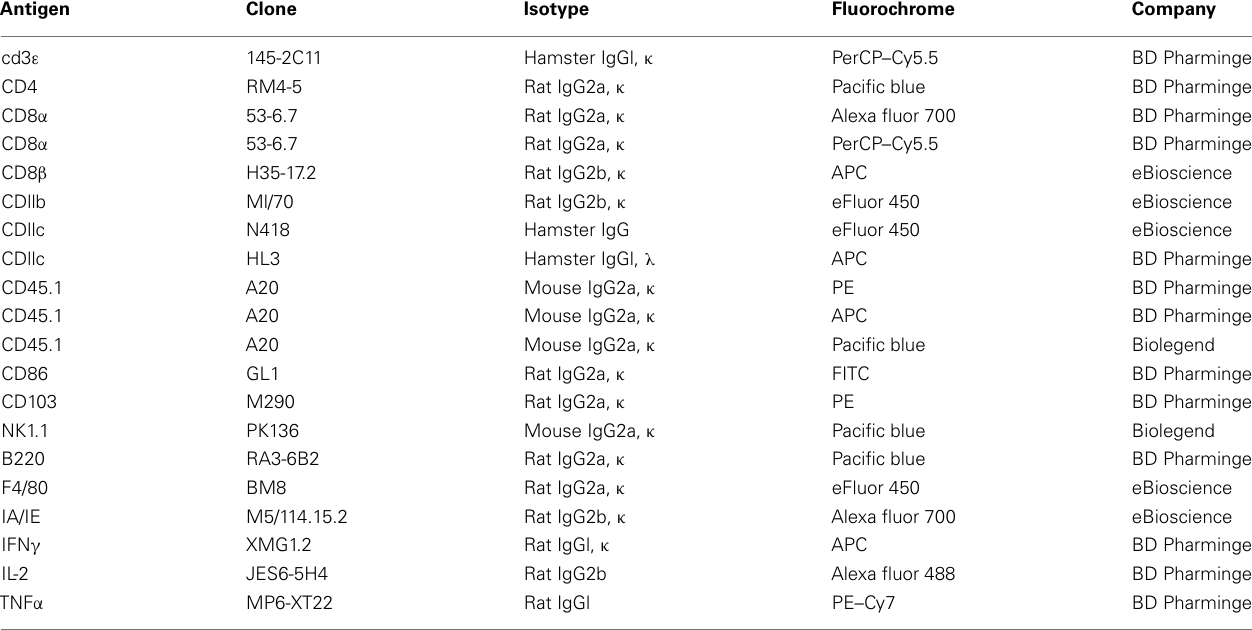
TableA1 |Antibodies used for flow cytometry